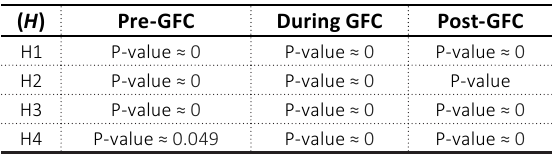
Table 8. The overall p -value using Wilcoxon rank- sum test (one-tail) for a whole sample in each